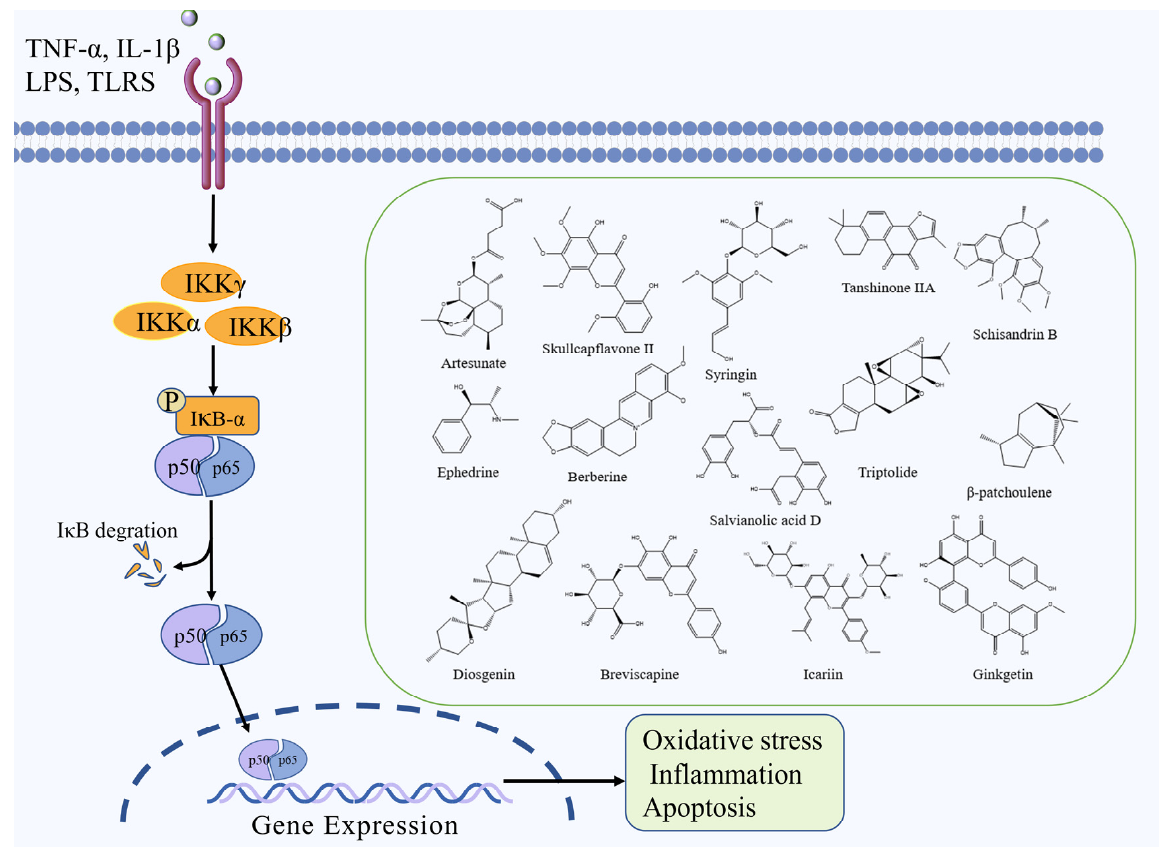
Figure 2. NF- κ B signaling pathway and the chemical structure of natural